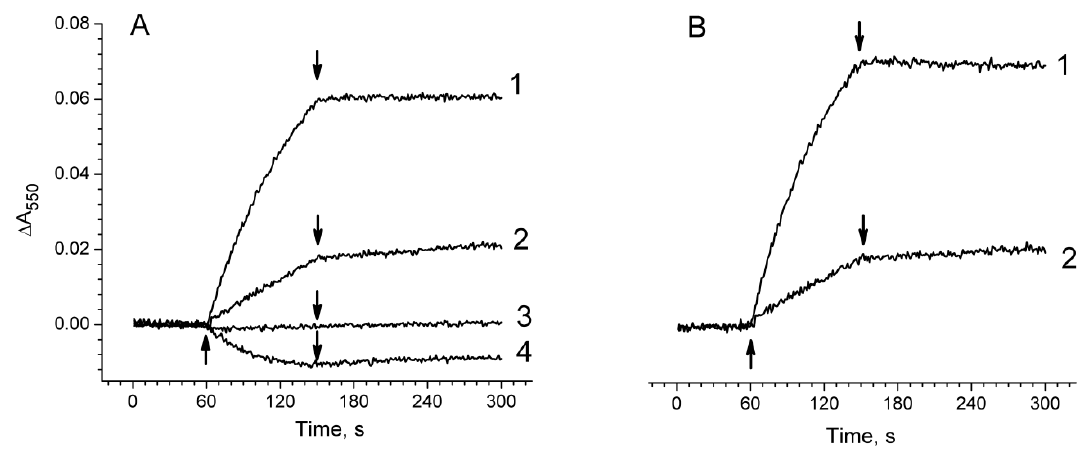
Figure 5. ( A ) Kinetics of Cyt c photoreduction by PSII core complexes before (2, 3) and after NH 2 OH treatment (1, 4). The measurements were done in the absence of additions (1, 2) and after the addition of 50 Un / mL SOD (3, 4). ( B ) Kinetics of Cyt c reduction associated with the light-induced O 2 −• formation in the PSII core complexes before (2) and after Mn removal (1). The kinetics was obtained by the subtraction of kinetics of Cyt c photoreduction measured in the presence of superoxide dismutase (SOD) from that measured in the absence of SOD. Reaction medium contained 50 mM MES–NaOH (pH 6.5), 35 mM NaCl, 0.4 M sucrose and 10 µ M Cyt c . The samples were illuminated ( λ > 600 nm, 1500 µ mol photon s − 1 m − 2 ) at chlorophyll concentration of 10 µ g / mL. Up and down arrows indicate light on and o ff , respectively.